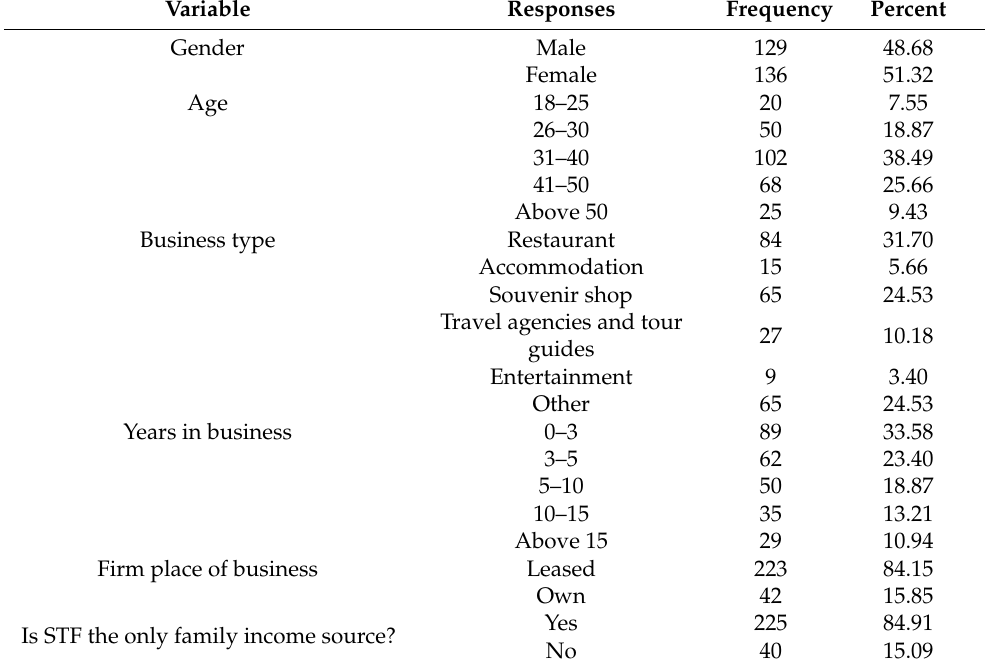
Table 2. Sample characteristics (N =